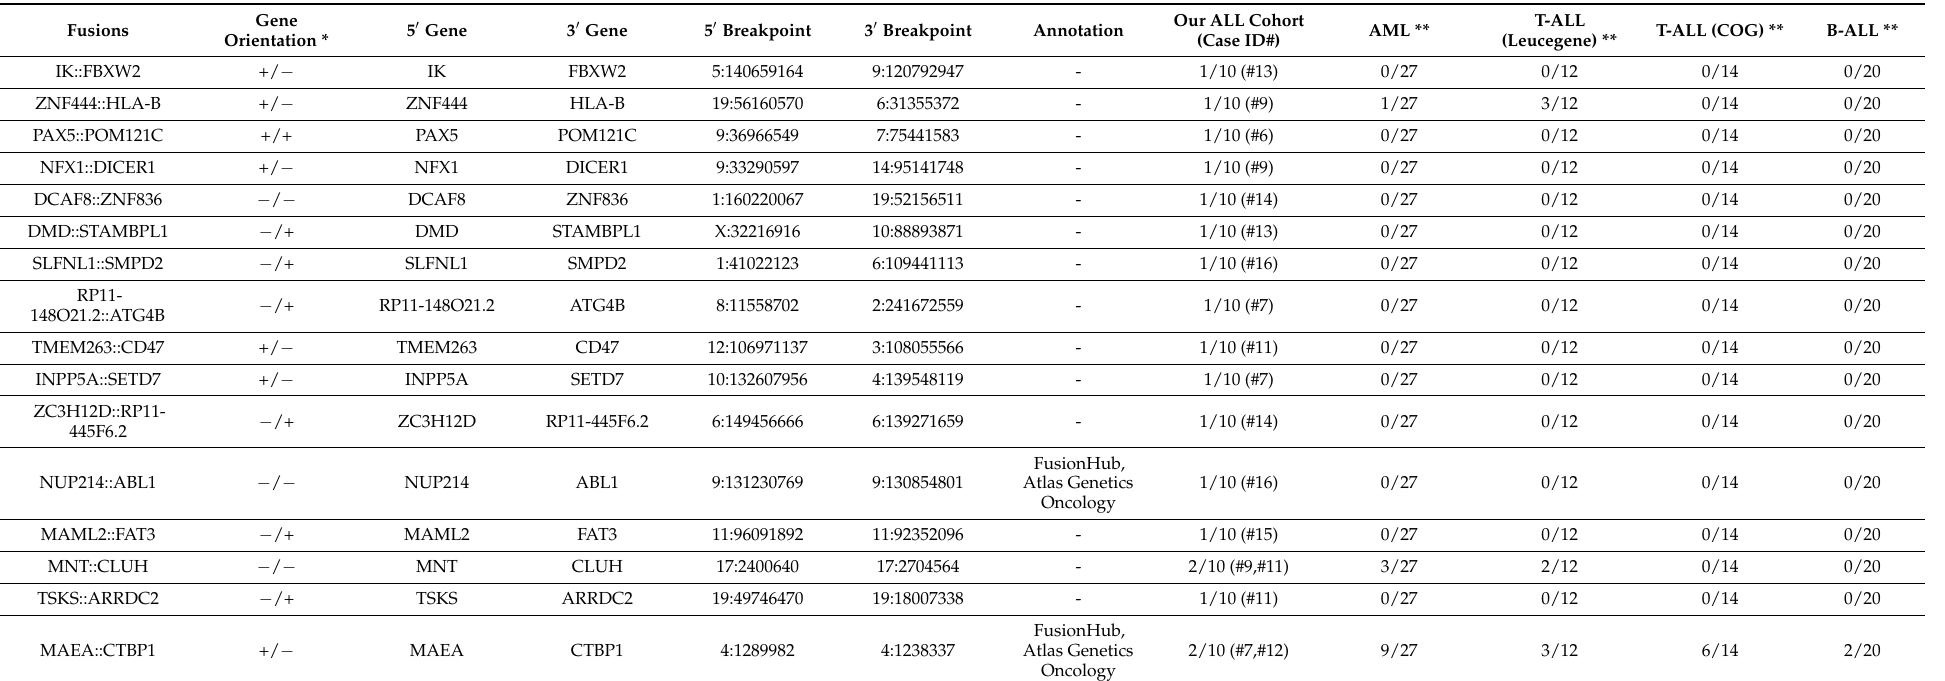
Table 4. Fusions identified in our ALL